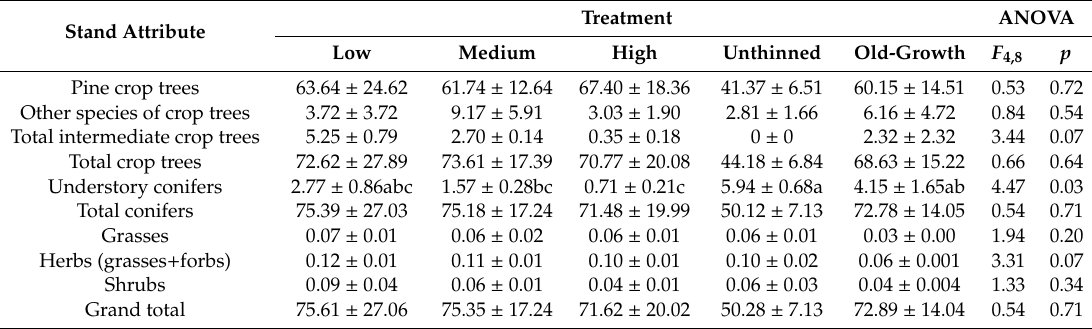
Table 4. Mean ( n = 3 replicate study areas) ± SE 25-year responses (1993 to 2018) of above- and below-ground carbon storage (Mg / ha) for lodgepole pine stands with three post-thinning (PCT) densities, unthinned, and old-growth treatments. Results of analysis of variance (ANOVA) are provided. Within a row, mean values with di ff erent letters are significantly di ff erent by Duncan’s multiple range test. Significant values in bold